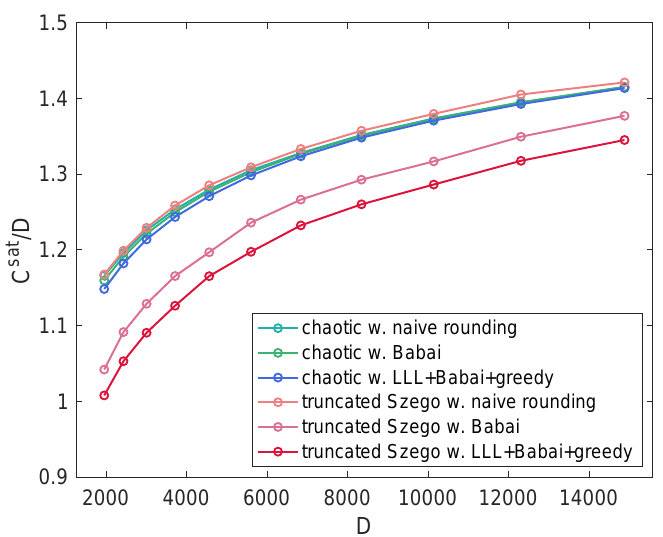
Figure 9: A comparison of different methods for solving the closest vector problem (CVP) that is central for the evaluation of the upper bound on complexity (2.30), as applied to a random resonant Hamiltonian and the truncated Szeg˝o system, at k =